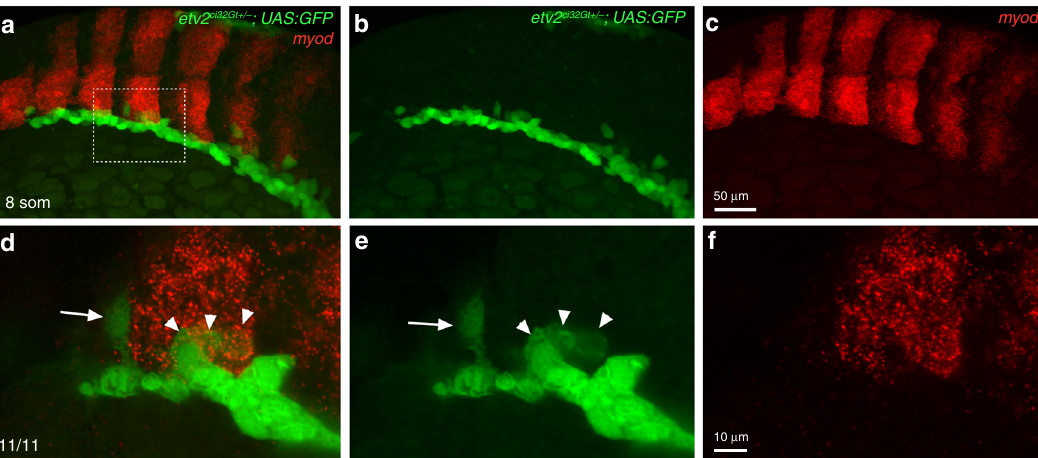
Fig. 5 Fluorescent in situ hybridization for myod expression in etv2 ci32Gt + / − ; UAS:GFP embryos. In situ hybridization was performed using hybridization chain reacion (HCR) at the 8 – 10-somite stages. a – c Maximum intensity projection is shown; d – f An area boxed in a was imaged at higher magni fi cation; maximum intensity projection of three confocal slices is shown. Note that most GFP-expressing cells are positioned in the lateral plate mesoderm, while some cells are starting to migrate toward the midline (arrow, d , e , points to a migrating angioblast which does not have myod expression). GFP and myod co-expressing cells (arrowheads, d , e ) are apparent at the posterior edge of the somite. The punctate myod expression pattern is due to the nature of the HCR probe. Dorsolateral view, anterior is to the left. The numbers in the lower left corner display the number of embryos showing the phenotype out of the total number of embryos analyzed in two replicate experiments.